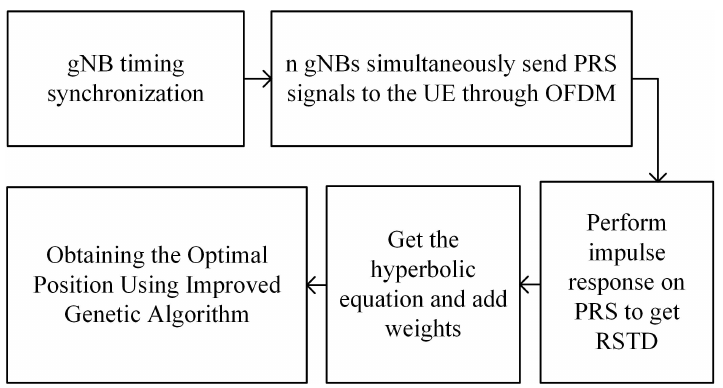
Figure 4. Hyperbolic positioning